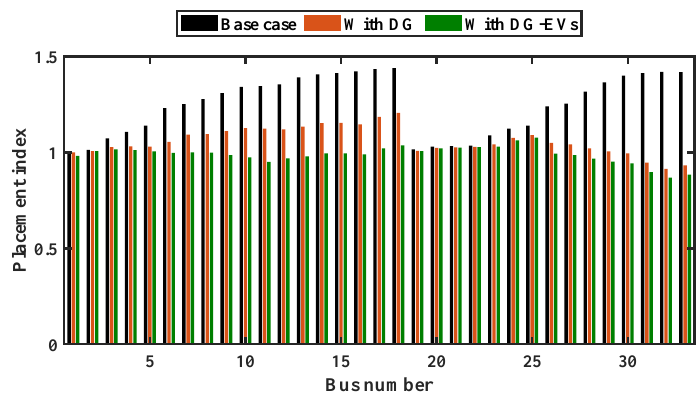
Figure 6. P-indexes at 33 buses of modified test